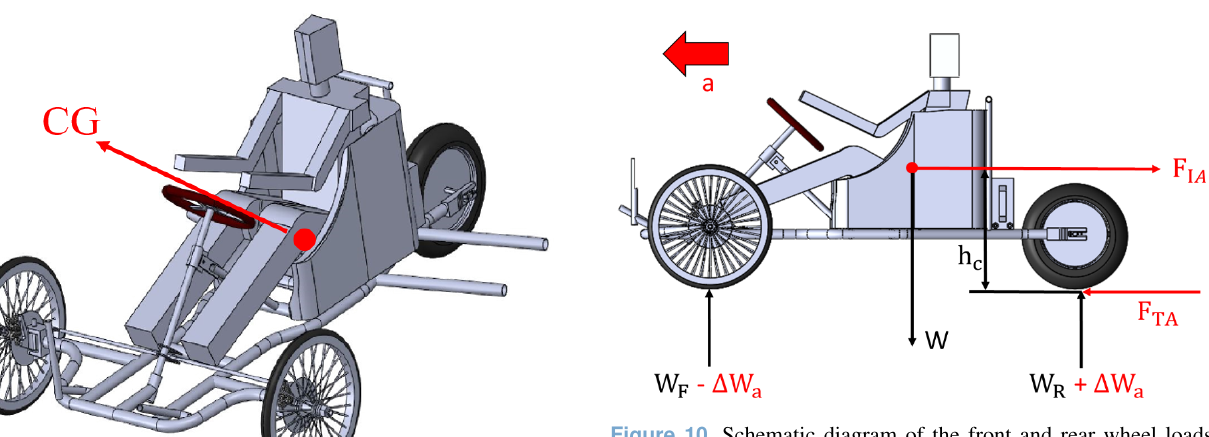
Figure 10. Schematic diagram of the front and rear wheel loads (acceleration).